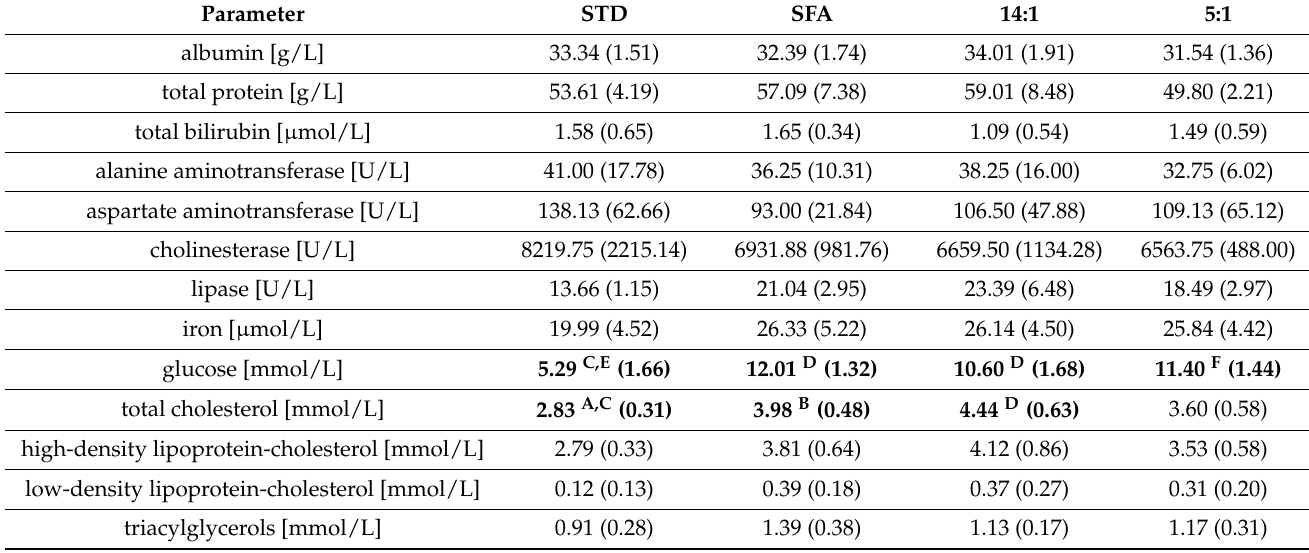
Table 2. Plasma biochemical parameters after three-month diets—the standard (STD), the experimental diets (SFA, 14:1 and 5:1)—expressed in arithmetic mean values (SD) (8 per group).